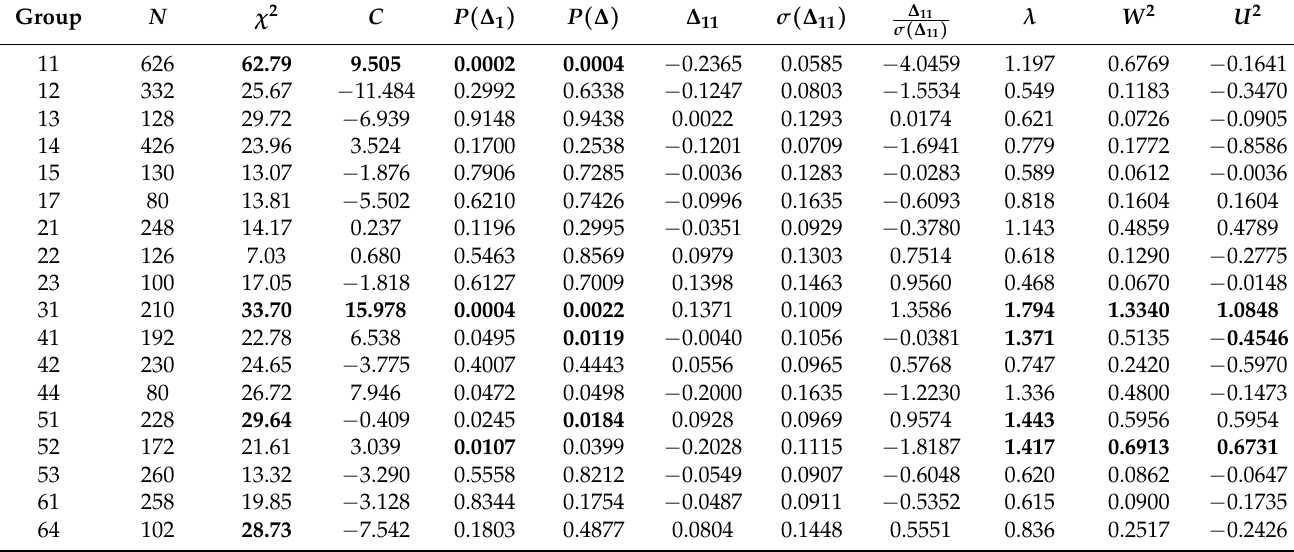
Table 1. Test for the isotropy of the orientations of the galaxy plane. The distribution of the angle δ D of galaxies; inclination was taken directly from the NBG Catalog.